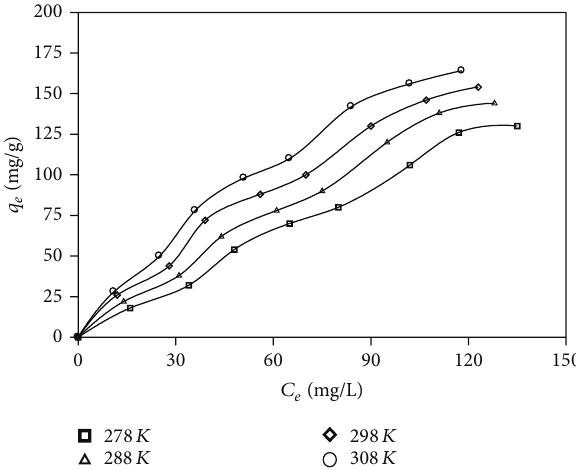
Figure 3: Effect of temperature on the adsorption of 2,6-xylenol onto asphaltene.